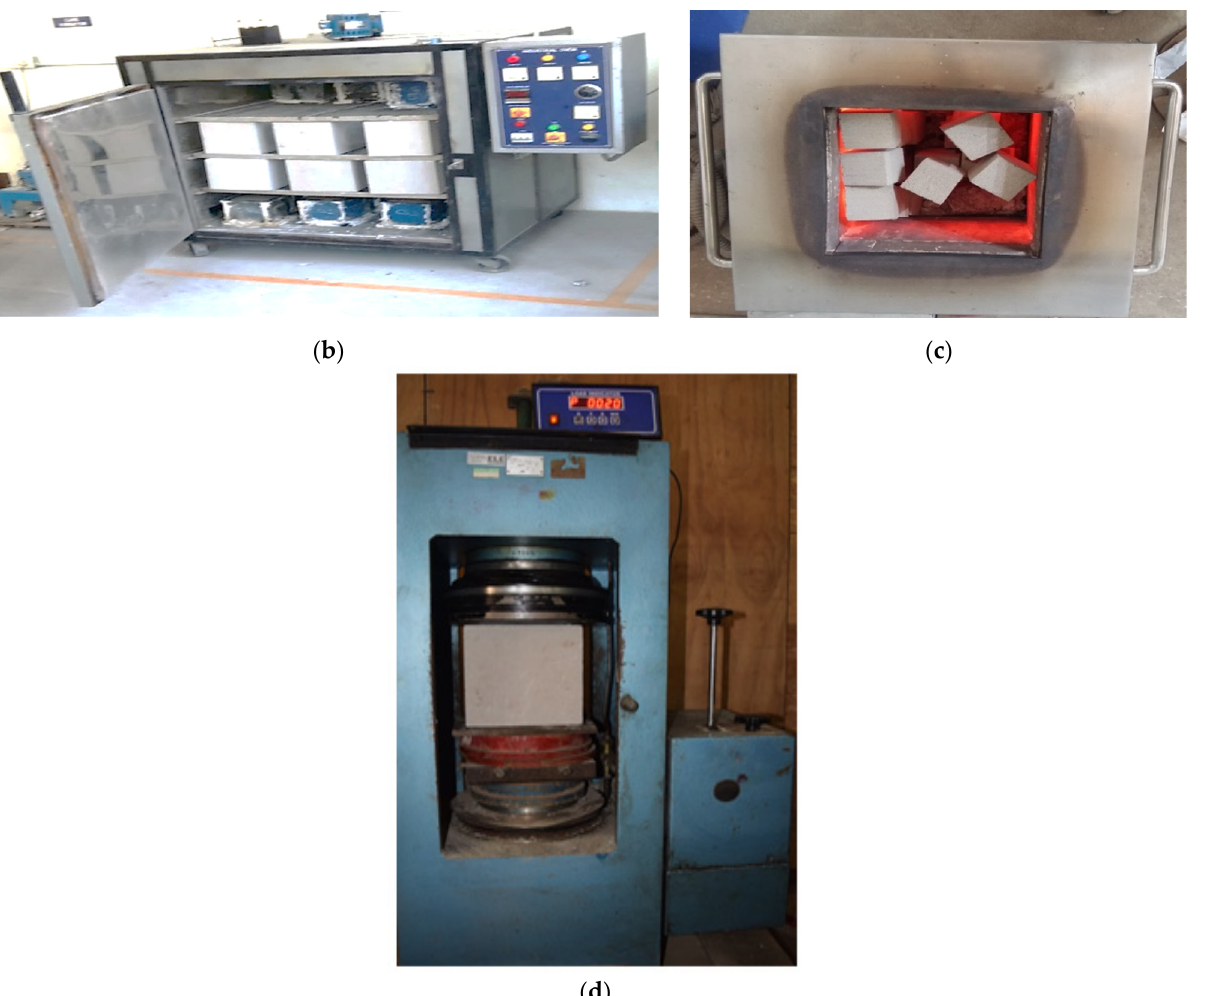
Figure 10. ( a ) Specimens used for testing; ( b ) pre-curing of specimens; ( c ) specimens placed in an autoclave; ( d ) compressive strength test.